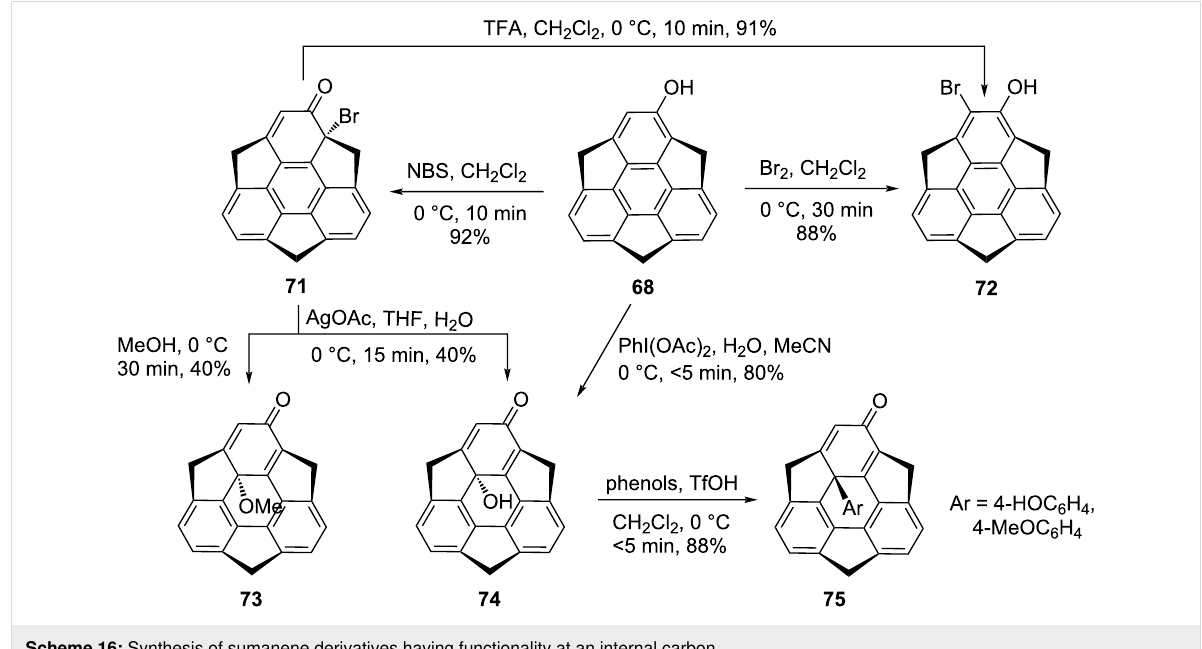
Scheme 16: Synthesis of sumanene derivatives having functionality at an internal carbon.